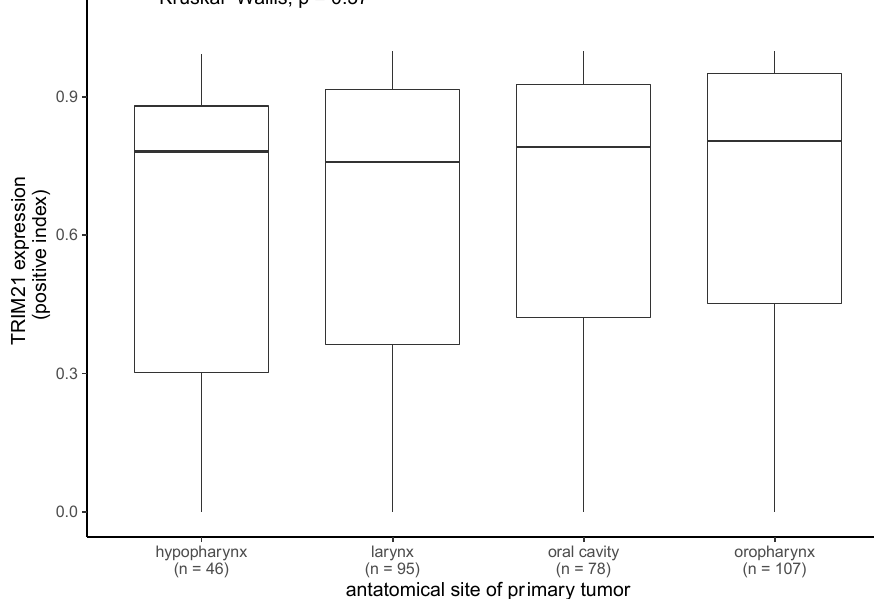
Figure 4. TRIM21 expression in primary tumors regarding their anatomical site of origin. TRIM21 expression in primary tumors did not significantly differ in regard to their anatomical site of origin (Kruskal–Wallis test, p = 0.37).